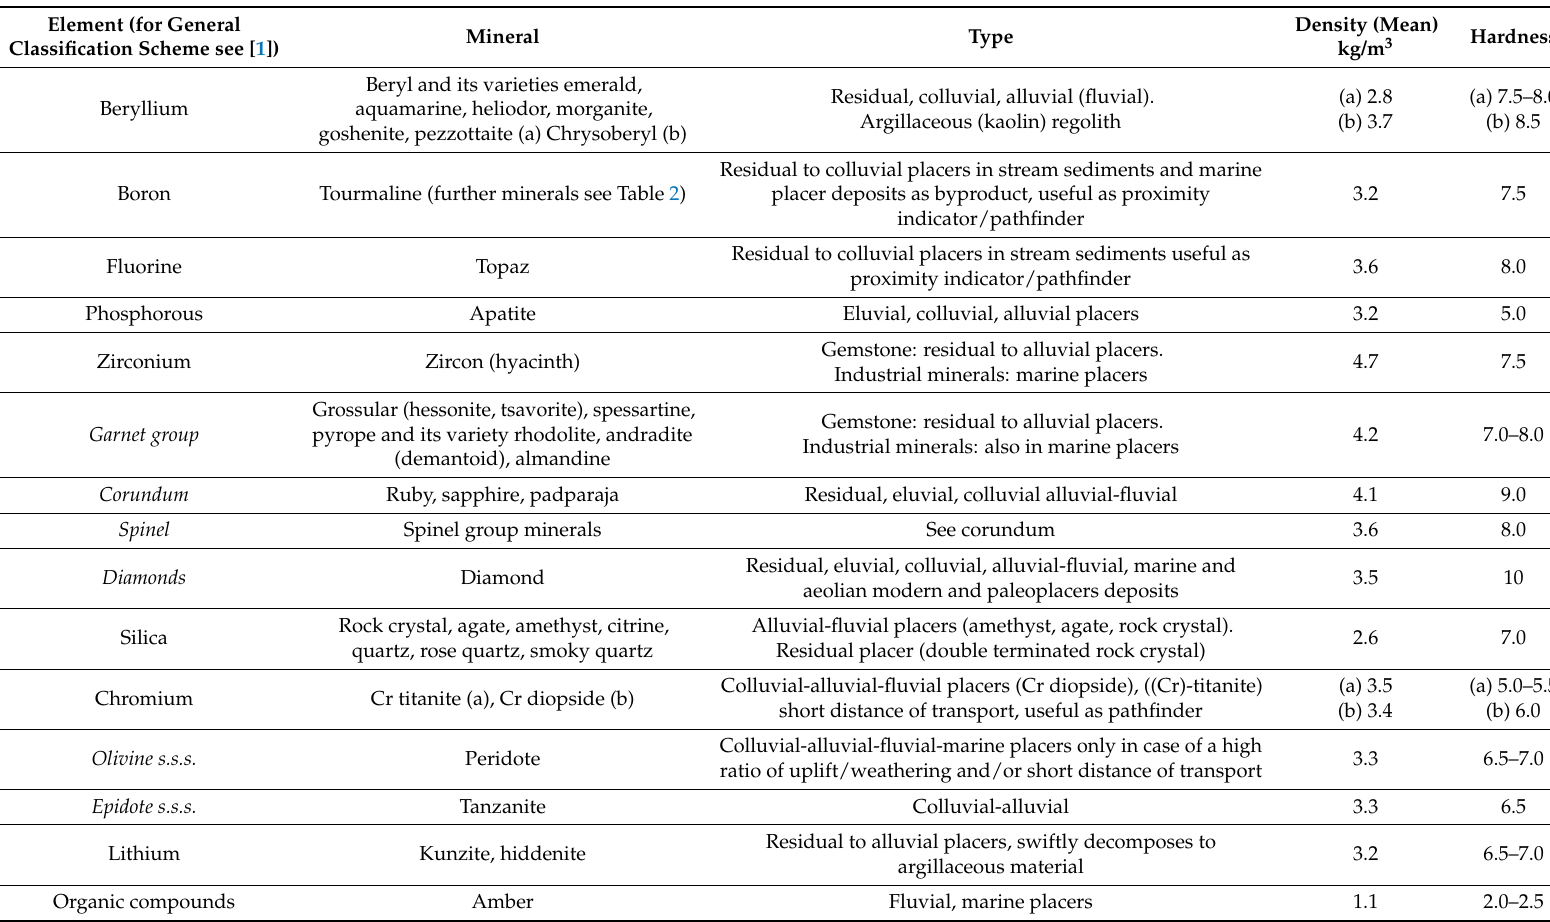
Table 1. Gem minerals found in placer deposits, their physical properties relevant for their emplacement clastic haloes around their source rocks and the sedimentary traps. The gem placer deposits are subdivided according to the “Chessboard classification scheme of mineral deposits” [1]—See Appendix A, so as to assist their assignment to the overall concentration processes of elements, minerals, and rocks during magmatic, metamorphic, and sedimentary